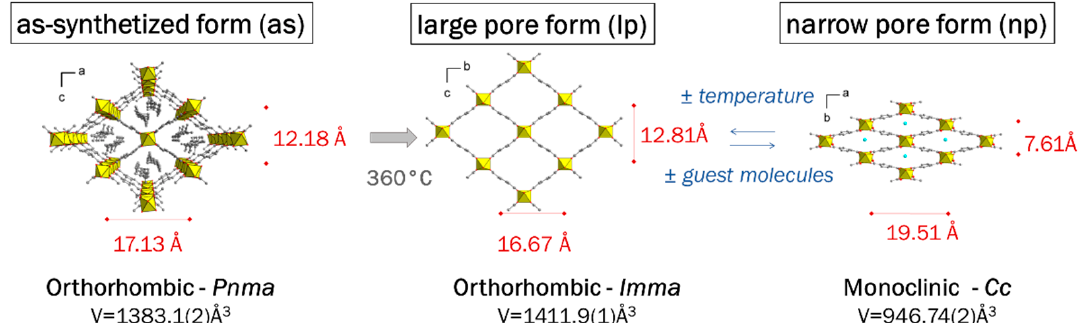
Figure 2. Structural transformation of the MIL-53 framework between its as-synthesized (as) (with free organic linker in the pore), open (lp) and contracted (np) forms (with water molecules in the pore). Aluminum octahedra, oxygen, carbon atoms and guest molecules are represented in yellow, red, grey and cyan, respectively.